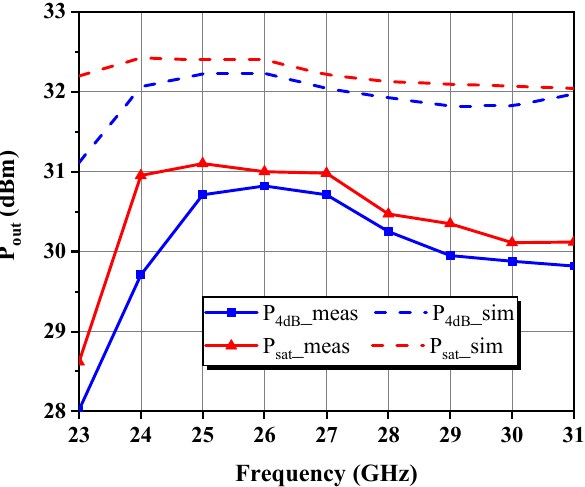
Figure 23 . Measured and simulated P out at 4 dB gain compression and in the saturation state. Figure 23. Measured and simulated P out at 4 dB gain compression and in the saturation